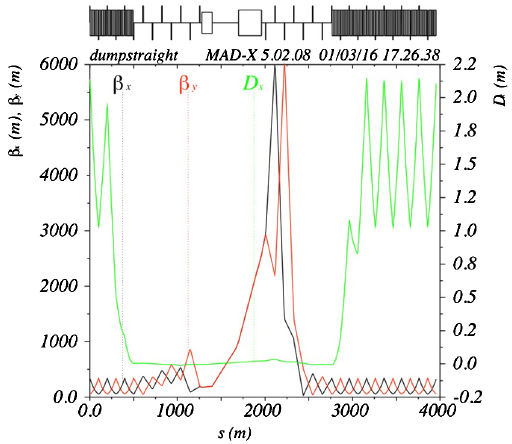
FIG. 3. Layout and optics of the dump concept. The dipole at the left end of the long central drift is the extraction kicker, followed by the extraction